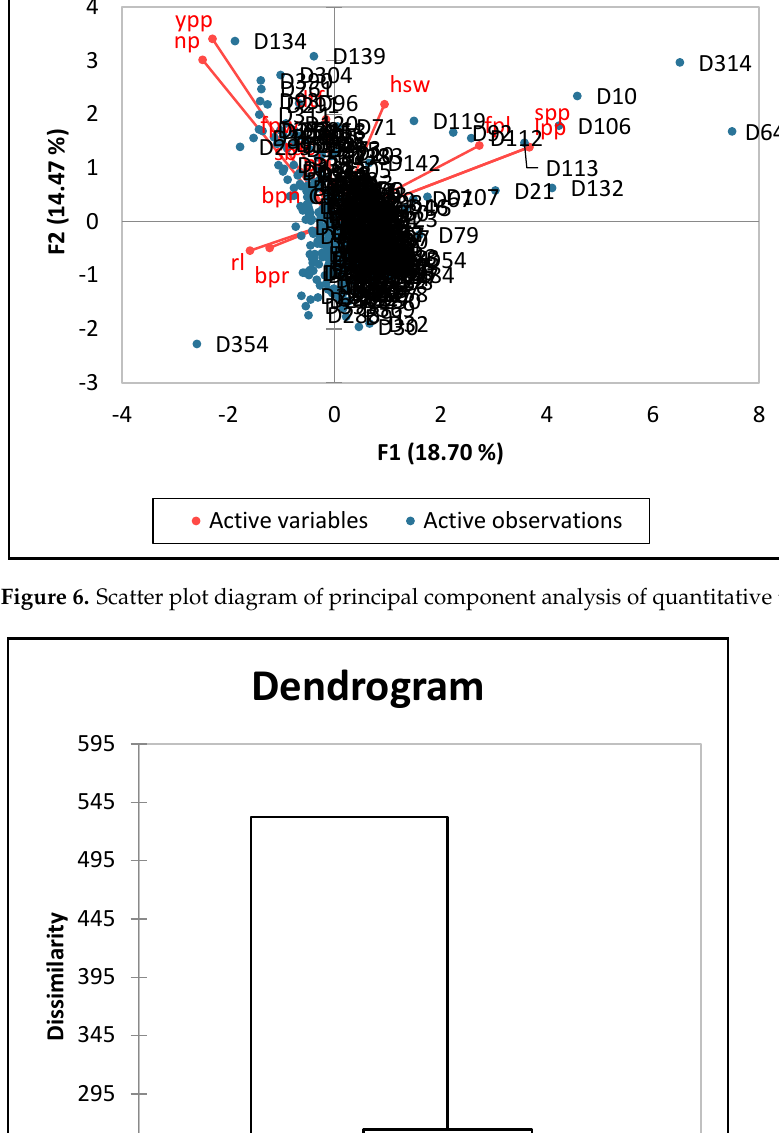
Figure 7. Cluster dendogram of 274 lablab accessions based on mean values of 14 quantitative traits over two cropping seasons.